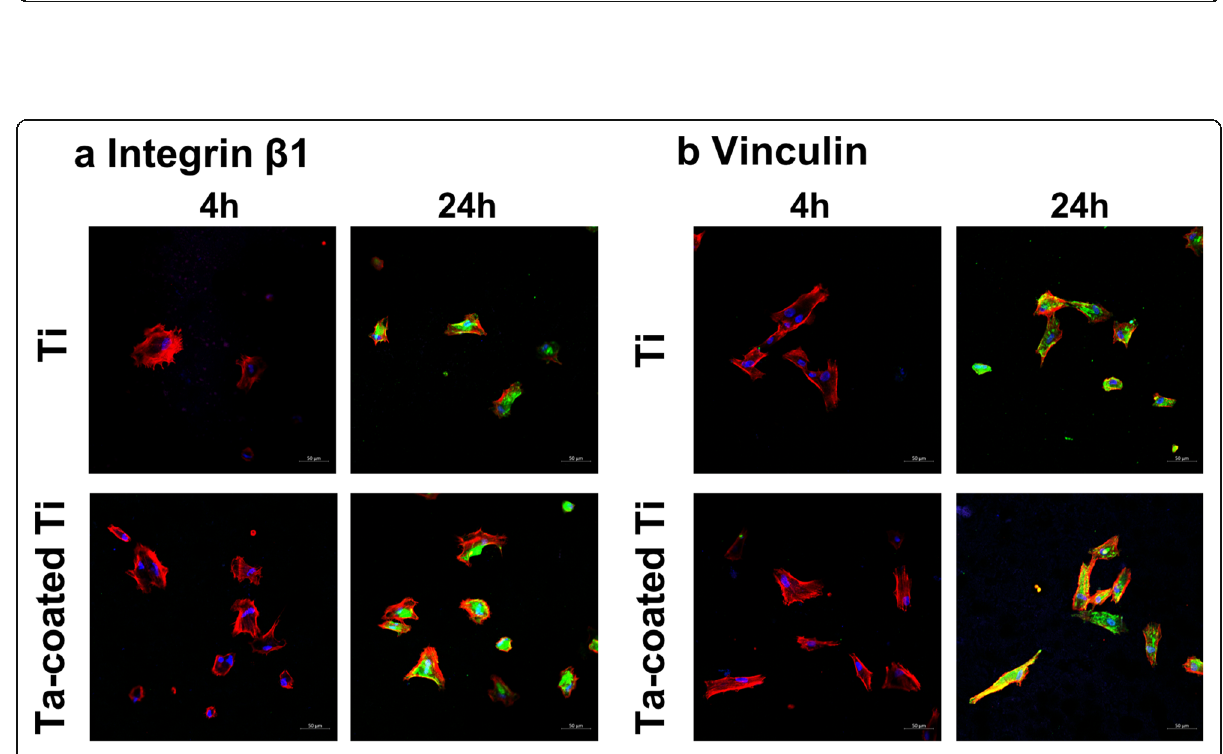
Fig. 5 Wound healing assay of HGFs on both samples at 0, 6, 12, and 24 h. a Nuclei (blue) and actin filaments (red) were visualized by DAPI and rhodamine-phalloidin (× 100). b The quantification of wound heal percentages.* p < 0.001, ** p < 0.0001 when compared with the Ti group